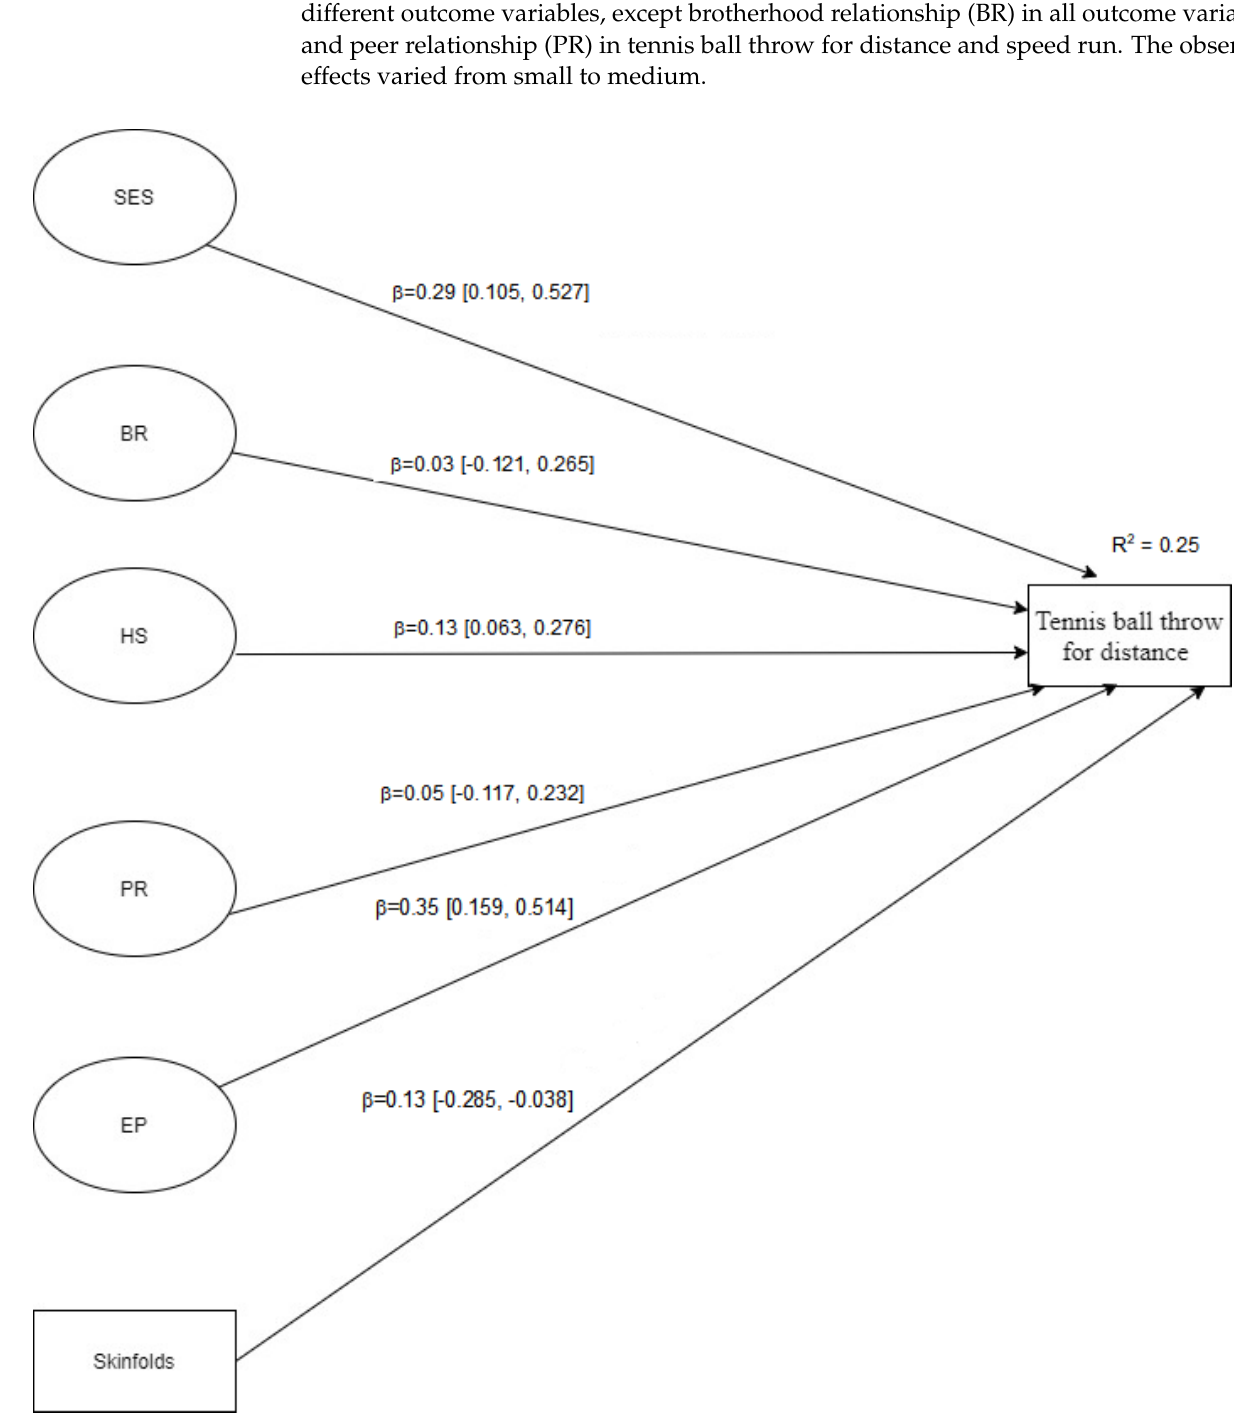
Figure 1. Structural model for tennis ball throw for distance. Note. SES = socio-economic status; BR = brotherhood relationship; HS = house space; PR = peer relationships; EP = educational practice; skinfolds = sum of 5 different skinfolds, including bi-acromial breadth, hip breadth, upper arm girth, standing calf girth, and upper limb length.